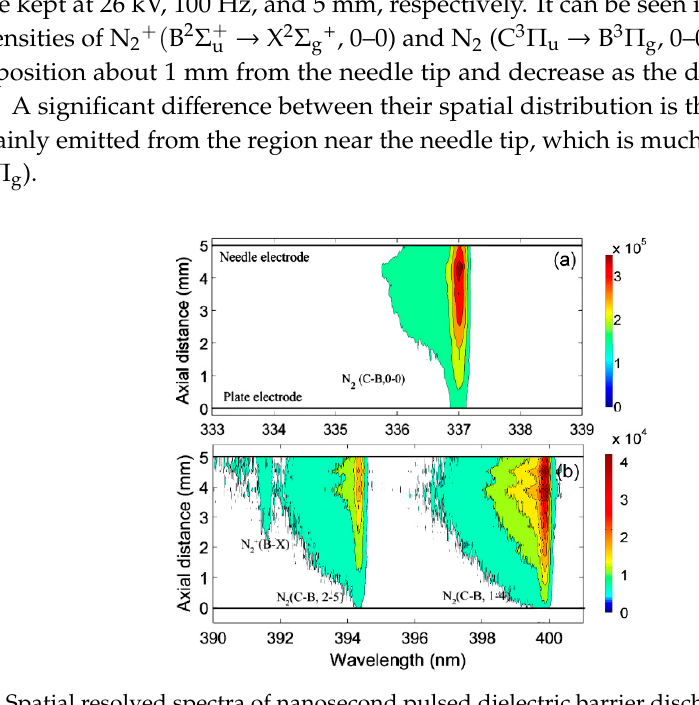
Figure 4. Spatial resolved spectra of nanosecond pulsed dielectric barrier discharge (NPDBD) ( a ) in range of 333–339 nm; ( b ) in range of 389–401